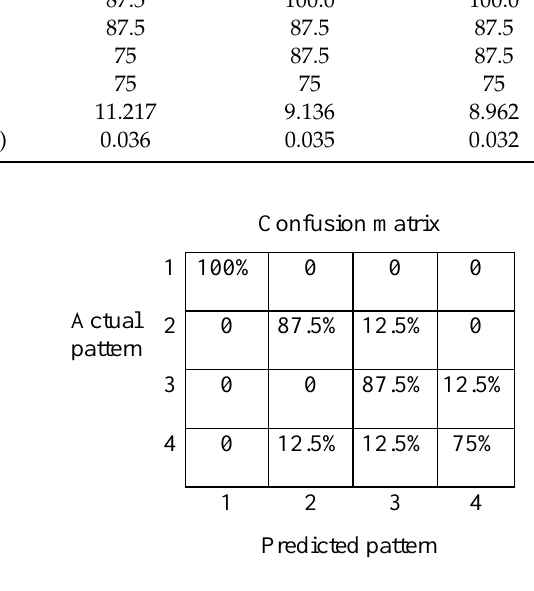
Figure 21. Confusion matrix of the of four patterns. Table 4. Classification recall, precision and F-score of FLCDT with p ˆ = 0.7.